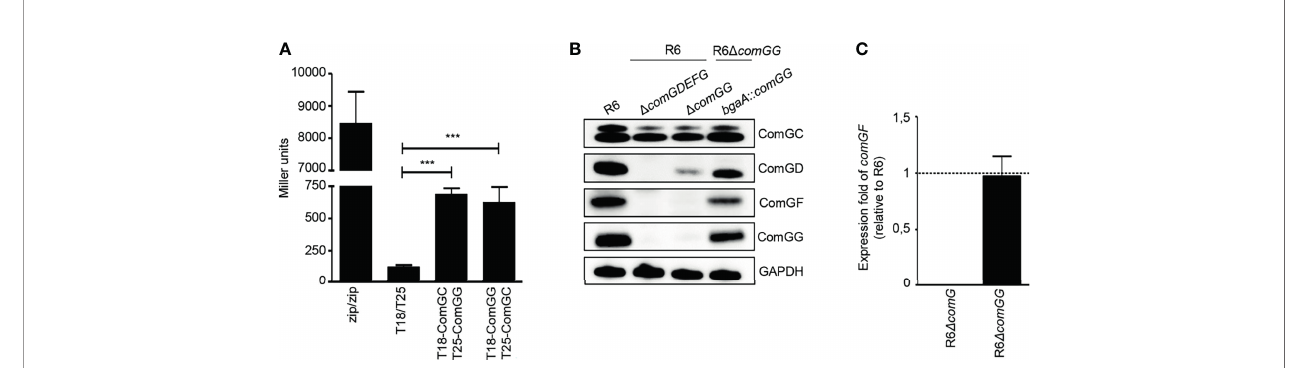
FIGURE 2 | ComGG interacts with ComGC and is required for the stability of ComGD and ComGF. (A) Quanti fi cation of the interaction between ComGG and ComGC by BACTH. The graph shows mean values of b -galactosidase activity expressed in Miller units for the hybrid proteins T18-ComGC/T25-ComGG and T18- ComGG/T25-ComGC. A strain expressing Zip-T18 and Zip-T25 (zip/zip), in which the hybrid proteins interact through a leucine zipper motif, was included as a positive control. E. coli BTH101 co-transformed with pUT18C and pKT25 empty plasmids was used as a negative control. The error bars represent the standard deviation of three independent experiments (n=3) with three different clones. A one-way analysis of variance test followed by Dunnett ’ s post-test to compare each interaction pair to the negative control (T18/T25) was used for statistical analysis: *** p ≤ 0.001. (B) ComGC, ComGD, ComGF and ComGG were detected by immunoblotting in bacterial whole cell lysates in the WT R6 strain, a mutant lacking all minor pilins ( D comGDEFG ) or comGG , and a complemented D comGG mutant strain that ectopically expressed comGG from the bgaA locus (R6 D comGG, bgaA :: comGG ). GAPDH was used as loading control. (C) Relative expression of comGF in competent R6 D comG and R6 D comGG. The R6 D comG operon mutant strain was included as negative control. Data was normalized to gyrA using the 2 - DD CT method and presented as the mean fold change of comGF relative to the WT R6 strain. Error bars represent the standard deviation of three independent experiments (n=3). The dotted line indicates an expression ratio of